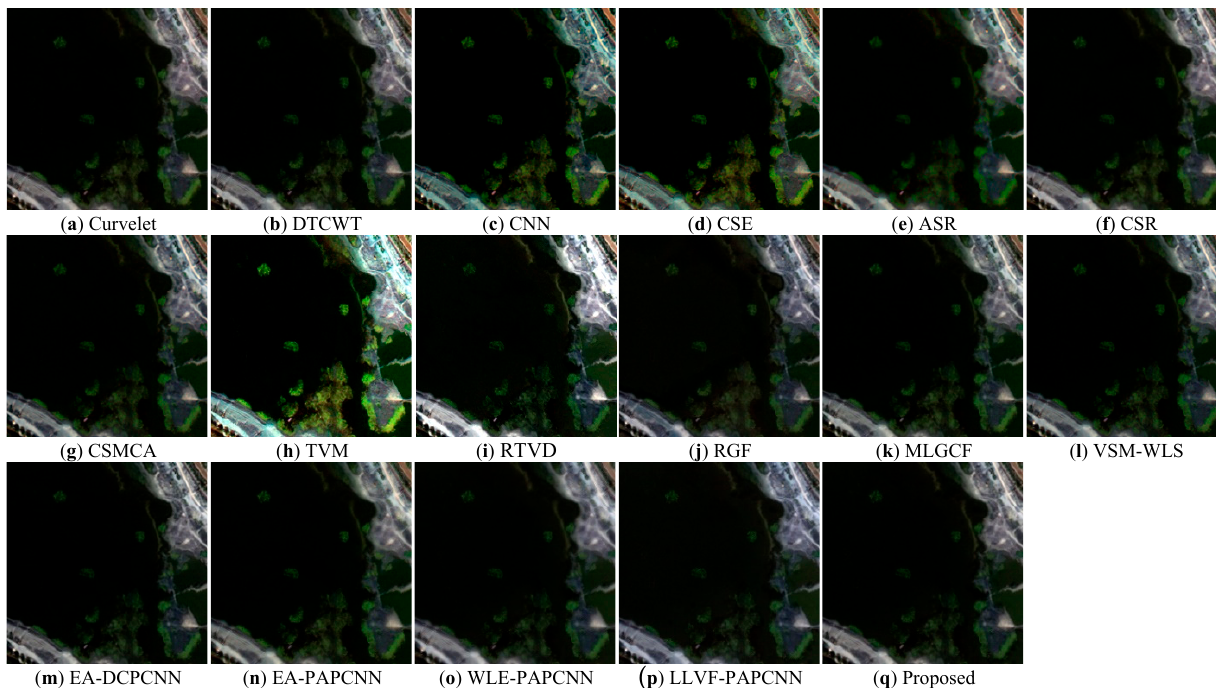
Figure 11. Fusion effect of WorldView-3 image.